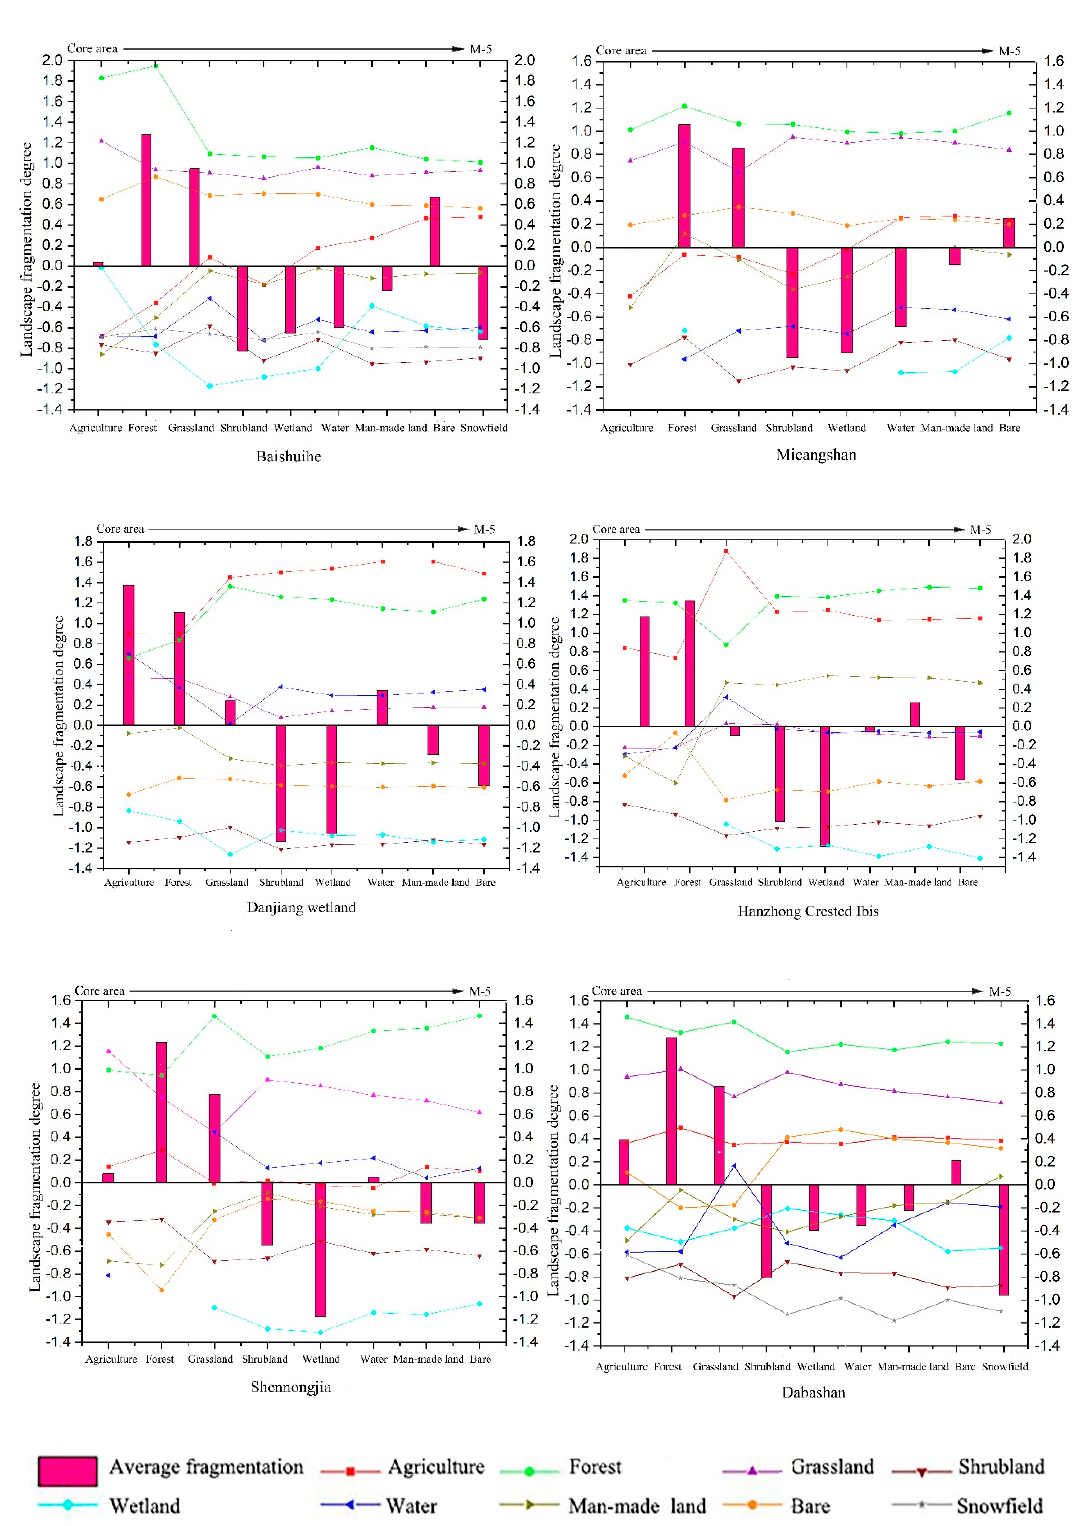
Figure 2. Fragmentation of core–edge landscapes in Qinling–Daba Mountains nature reserves.